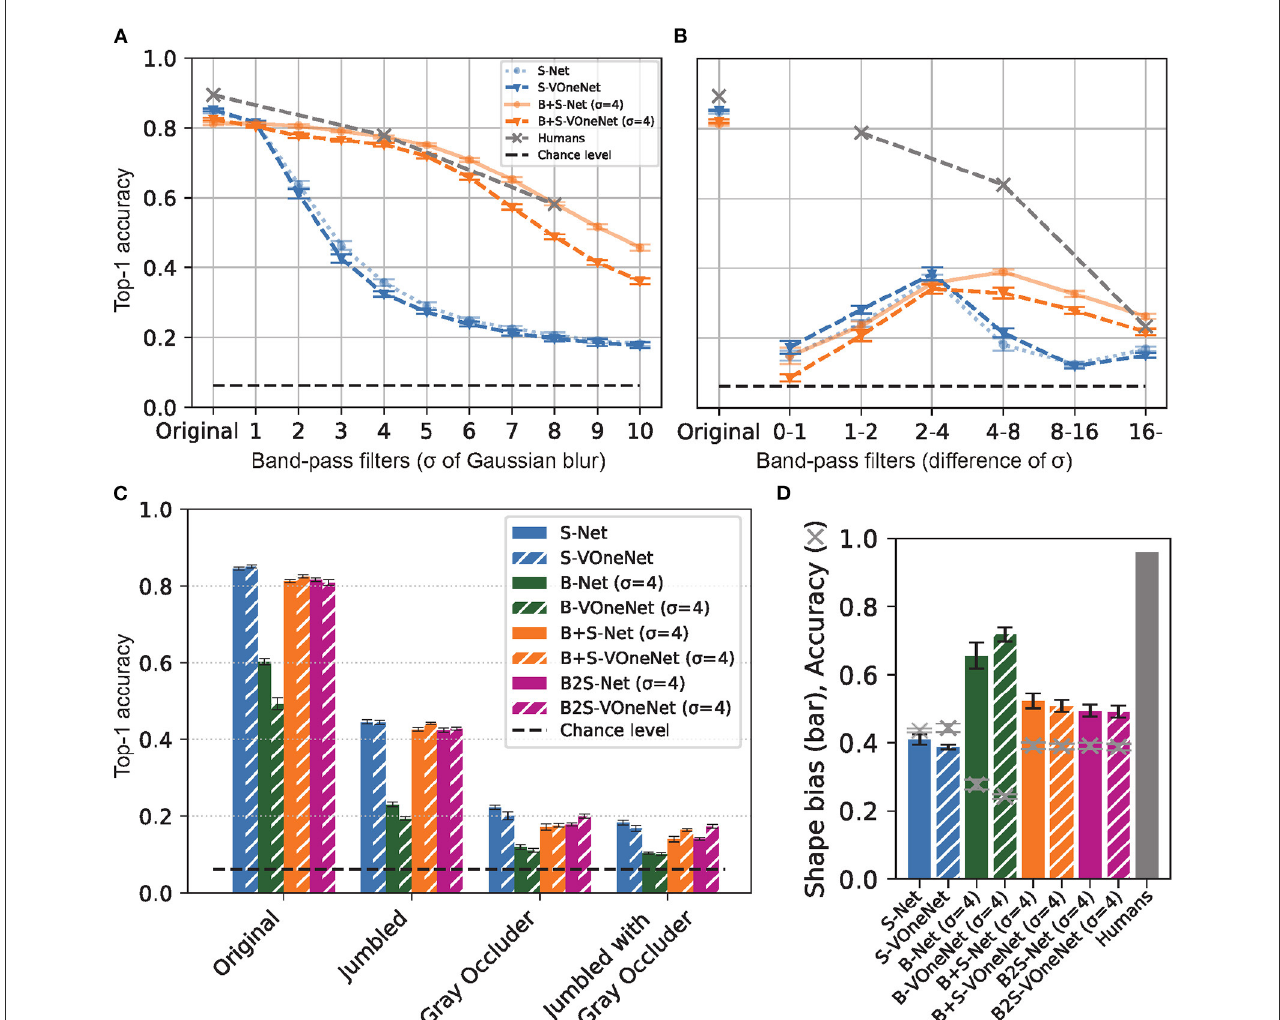
FIGURE3 VOneNet with blur training. (A) Low-pass filtered object image recognition. (B) band-pass filtered object image recognition, (C) jumbled/occluded image recognition, and (D) shape-texture-cue-conflict image recognition. Although VOneNet has fixed V1-like first-stage mechanisms, the effects of blur training are similar to those of AlexNet. Error bars represent 95% confidence intervals estimated from the performances of eight models trained with different random